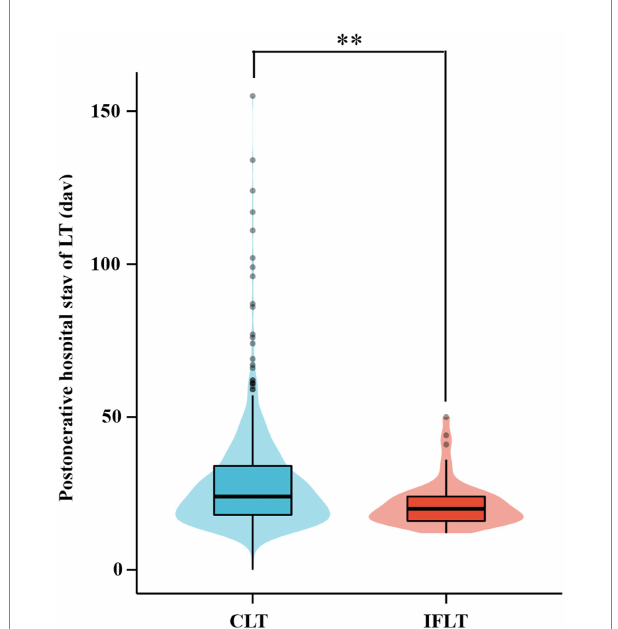
FIGURE 6 Comparison of postoperative hospital stay between CLT and IFLT in 2016 ~ 2019. CLT, conventional liver transplant. IFLT, ischemia-free liver transplant. LT, liver transplant. * p < 0.05. ** p < 0.01. *** p <